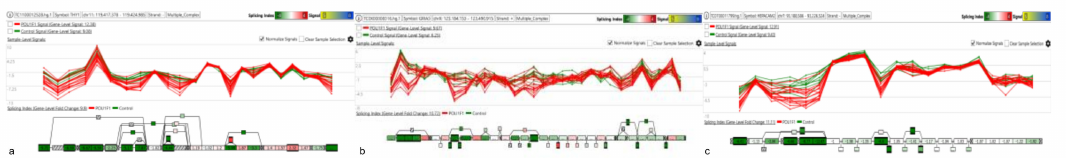
Figure 6. Panels ( a – c ) show the splicing events in CDK18 , PTGS2 and SEMA7A genes characterizing the NR5A1 tumors.